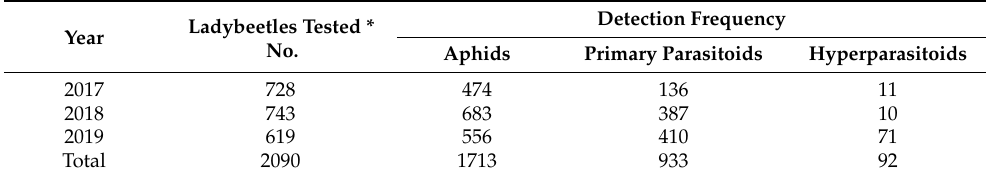
Table 2. Detection frequency of aphids, primary parasitoids and hyperparasitoids in field-collected Hippodamia variegata individuals. Detection Frequency Ladybeetles Tested * Year No. Aphids Primary Parasitoids